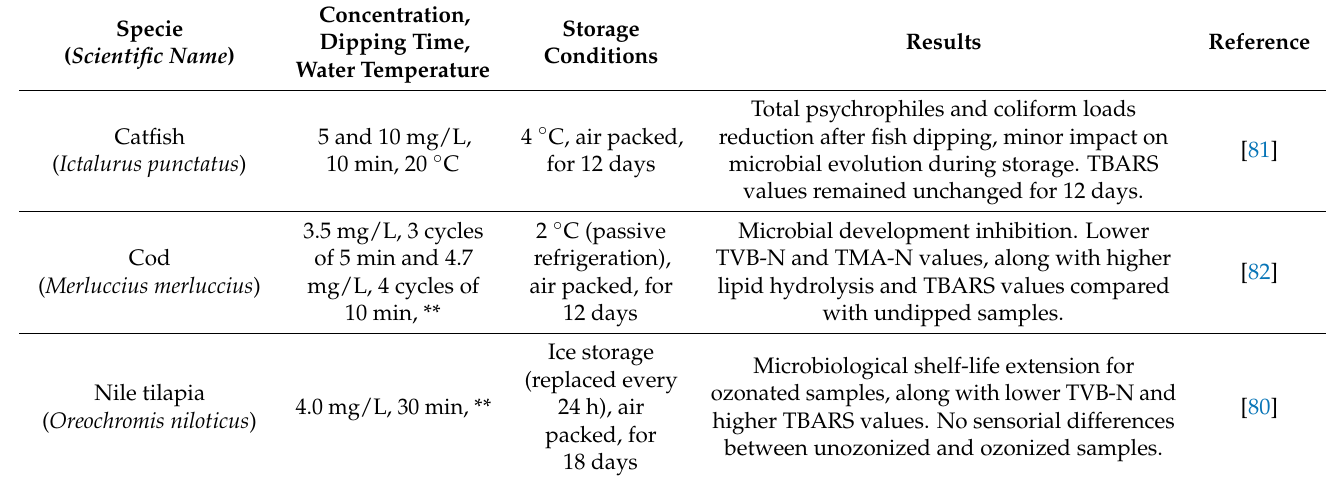
Table 4. Literature regarding the effects of dissolved ozone dipping and spraying on fresh